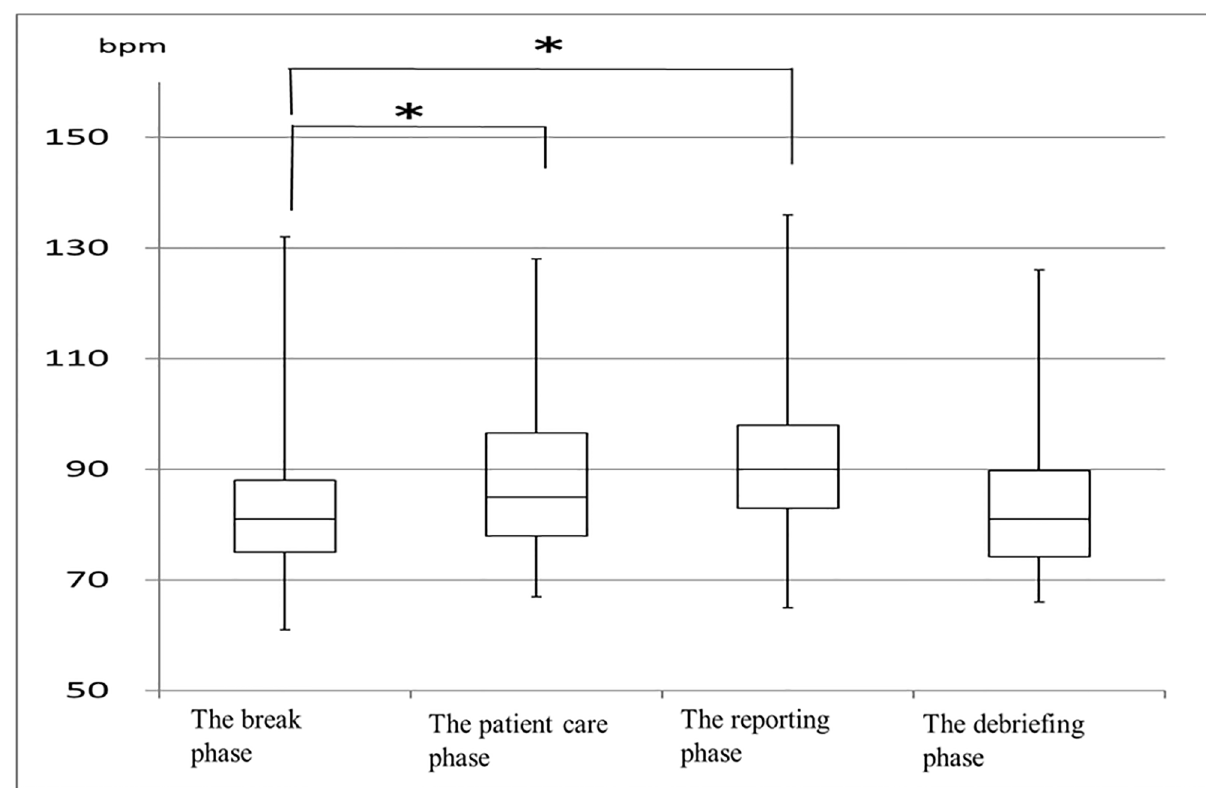
Fig 1. Changes in heart rate at each phase (n = 74) (cid:3) p < 0.05.